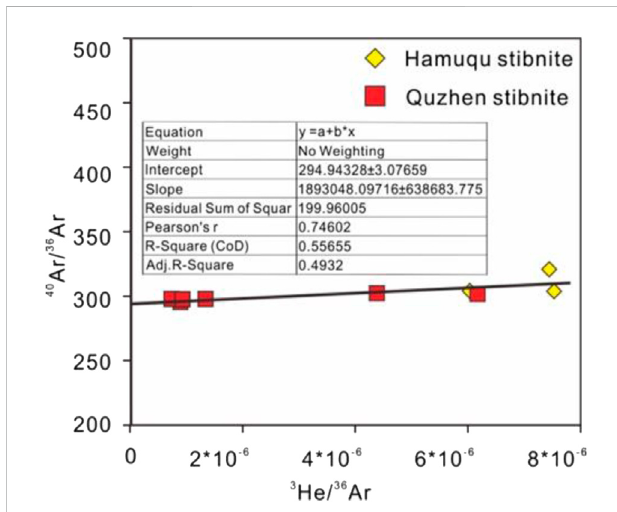
FIGURE 6 . Diagram of fl uid inclusions of 3He/36Ar-40Ar/36Ar in stibnite in the Abunabu antimony